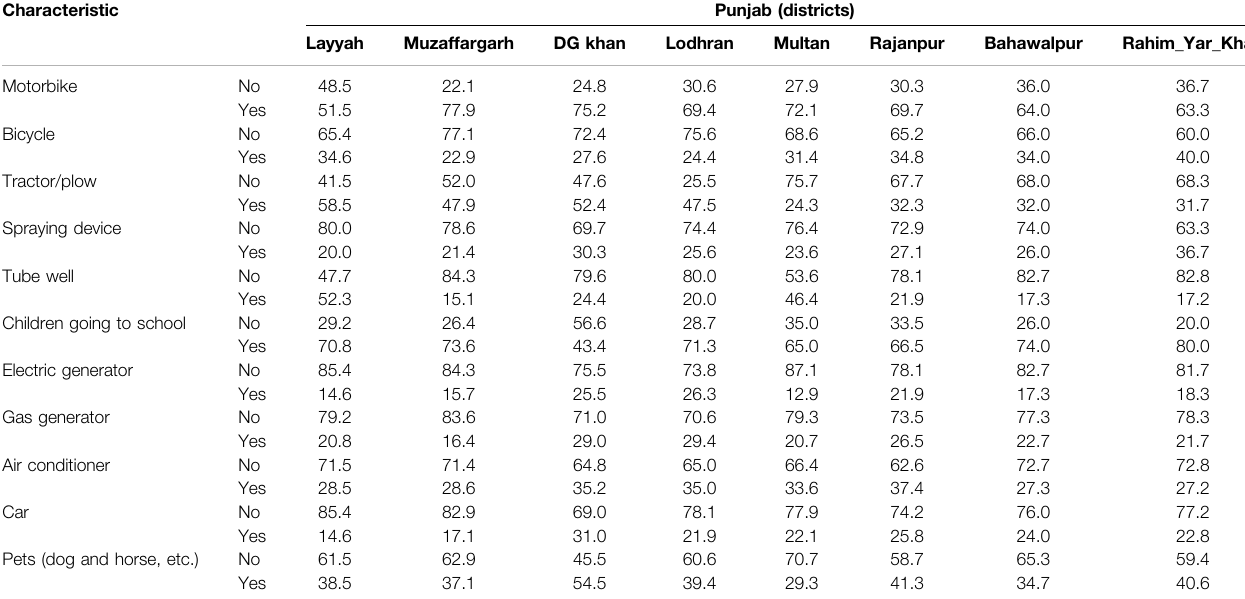
TABLE 3 | Farmer ’ s livelihood assets. Characteristic